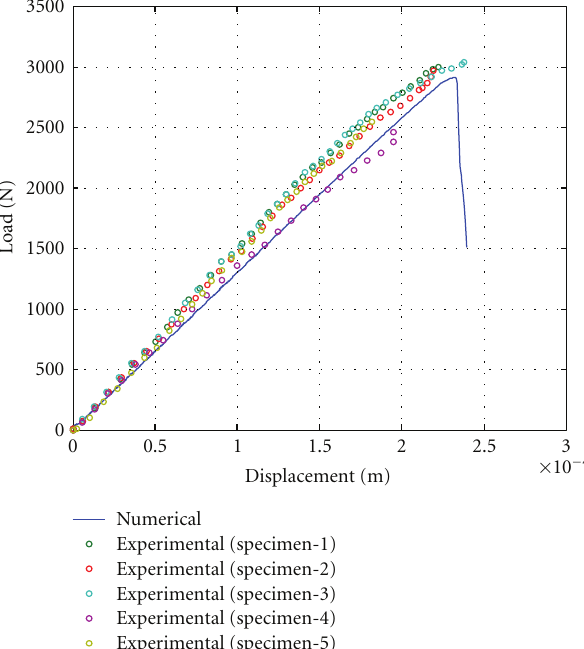
Figure 21: Comparison between numerical predictions and experimental results for the matrix compression